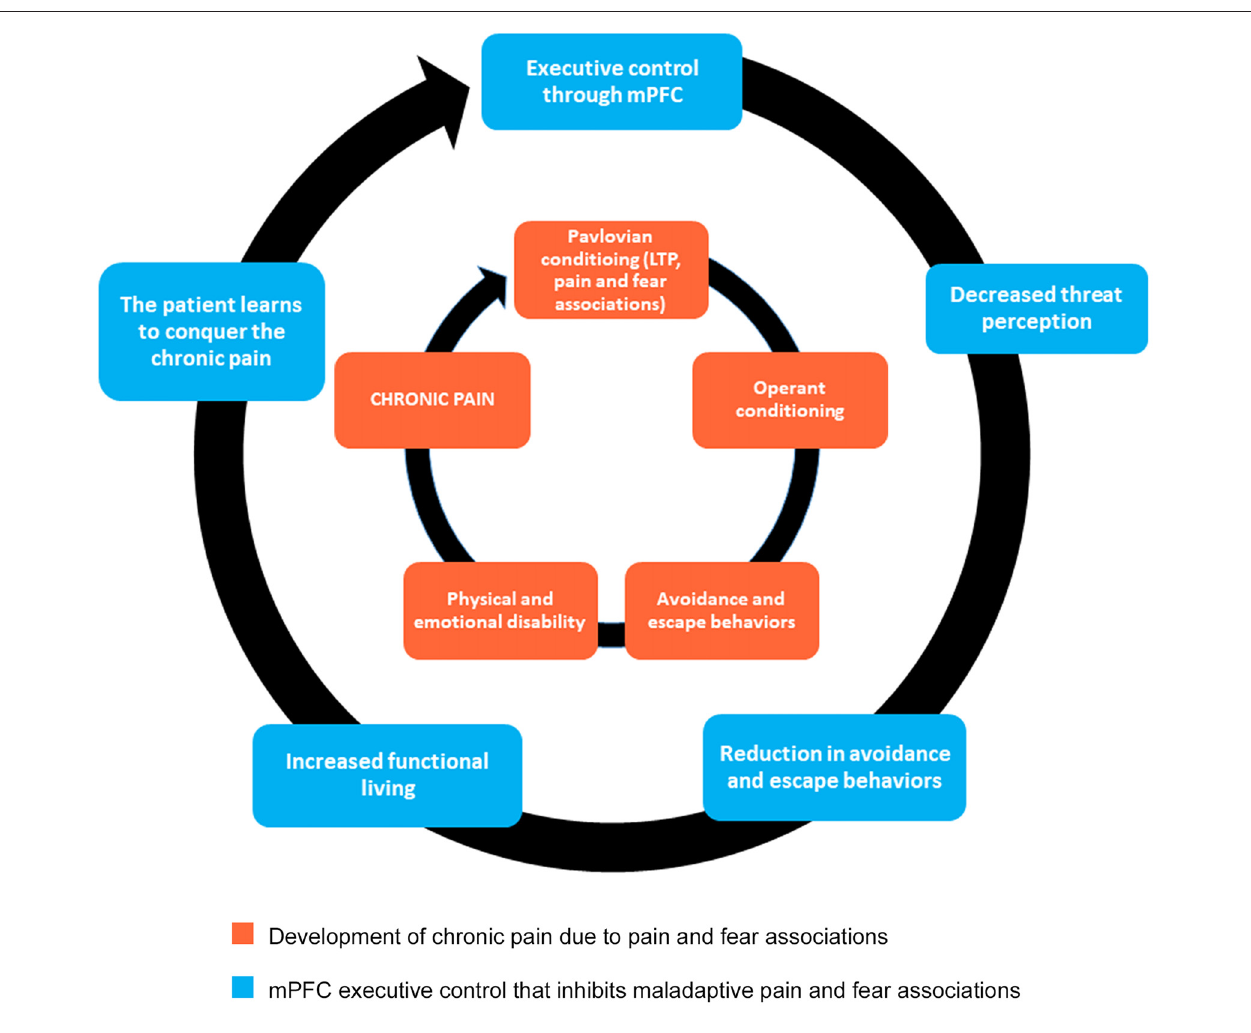
FIGURE 2 | Mind-body approach to healing that promotes executive control originating from mPFC. The inner circle indicates the behavioral mechanisms underlying chronic pain. This approach to healing, grounded in cognitive reappraisal, mindfulness meditation, and functional rehabilitation, will promote new synaptic connections necessary for fear extinction (outer circle). Notice that the inner circle does not go away. Instead, by strengthening the components of the outer circle, the mPFC can exercise executive control by inhibiting maladaptive pathways (inner circle). As a result, chronic pain patients learn how to better cope with pain, in essence giving them the power to conquer the debilitating nature of their